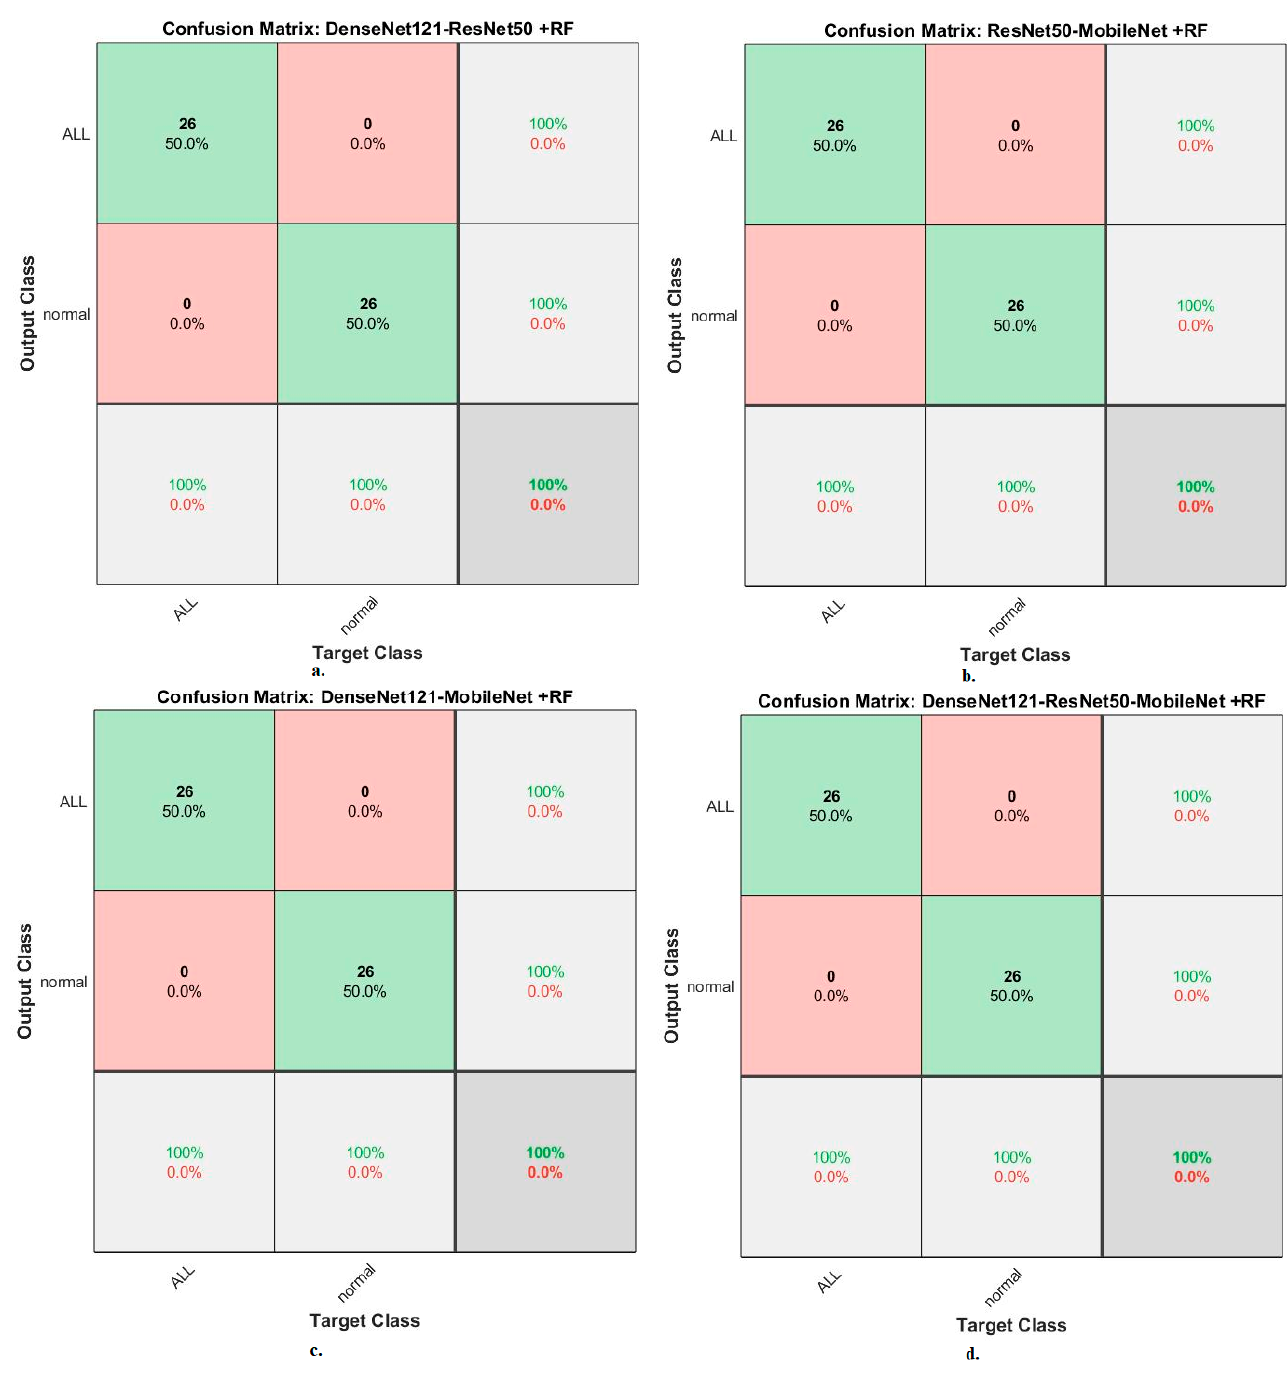
Figure 17. Results of the RF classifier based on fusion features of the CNN models of the ALL-IDB2 dataset for the diagnosis of acute leukemia, confusion matrix of ( a ) DenseNet121-ResNet50, ( b ) ResNet50-MobileNet, ( c ) DenseNet121-MobileNet, and ( d ) DenseNet121-ResNet50-MobileNet. The XGBoost classifier with fusion CNN features produces a confusion matrix, as